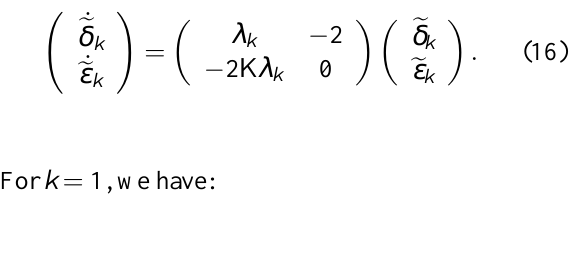
Fig. 1. Three types of network topologies with respective Fiedler number F ( · ) : “All to All” ( F AtA = − 5), “Crystal” ( F Cry = − 3) and “All to One” ( F AtO = − 1).